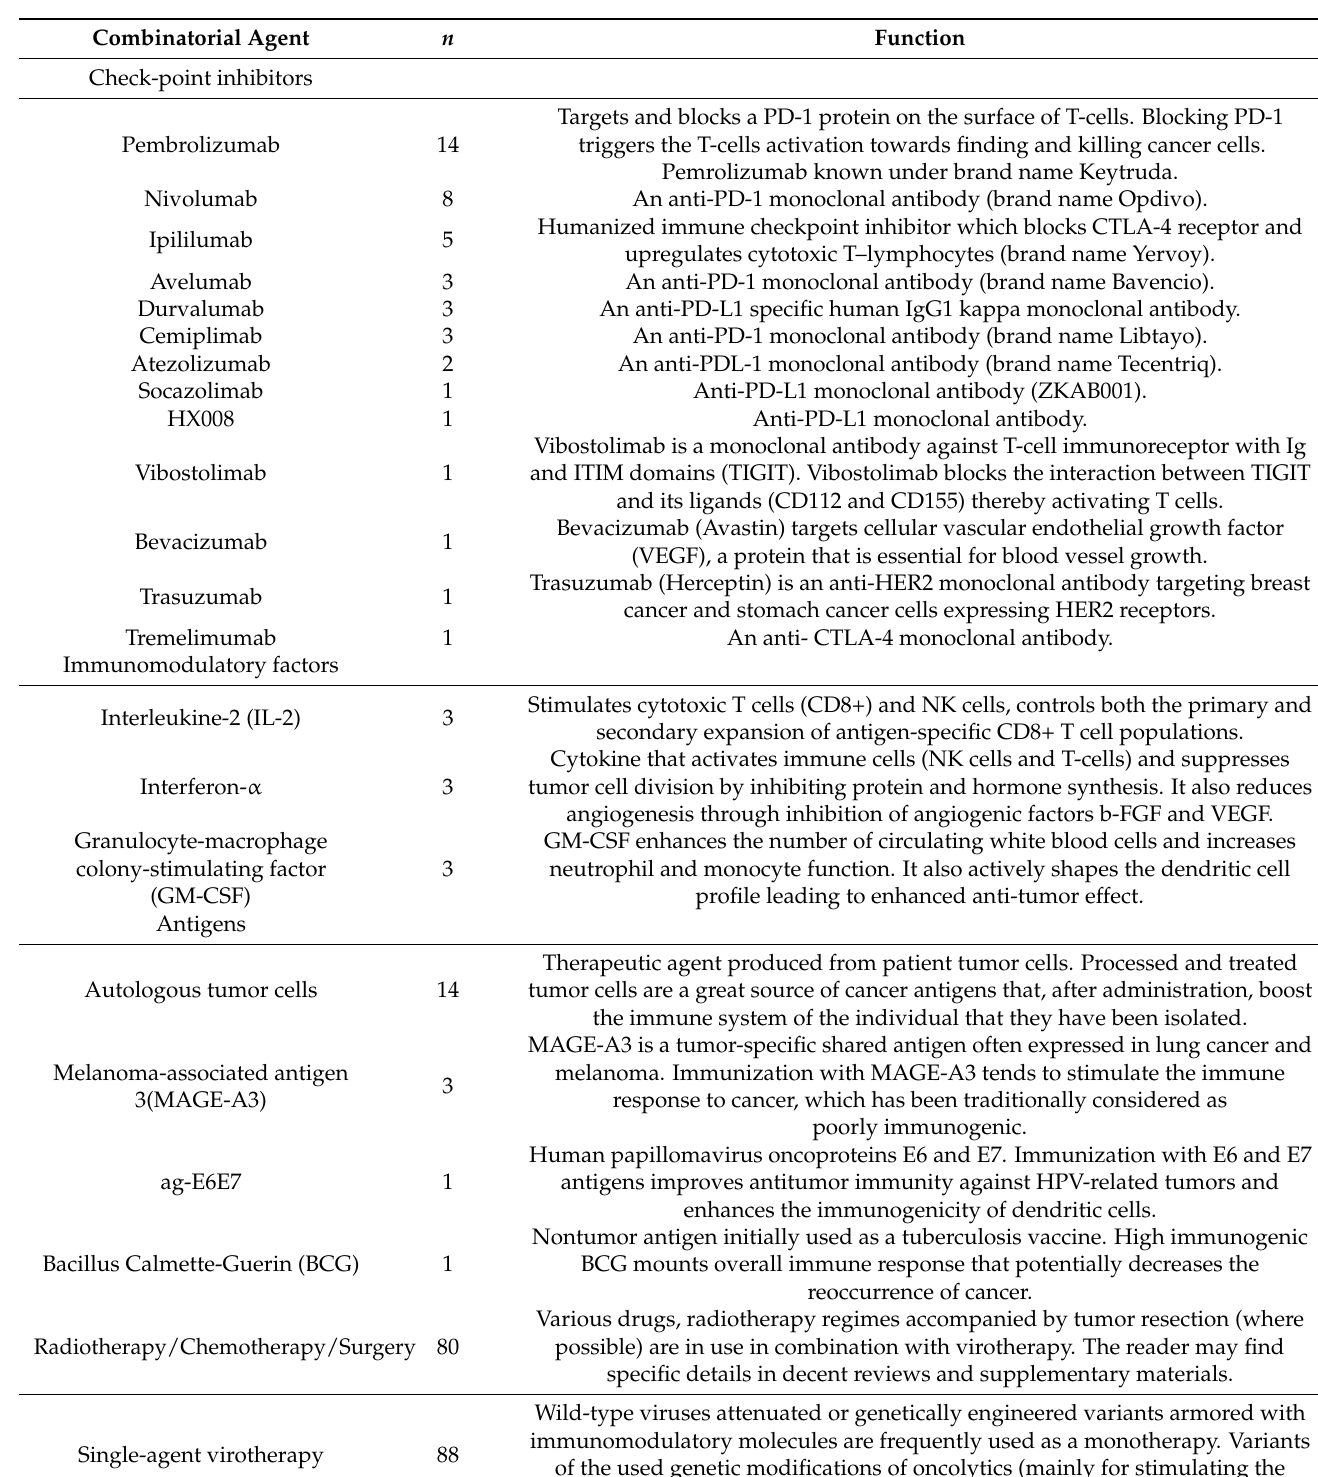
Table 1. Viral immunotherapy in clinical